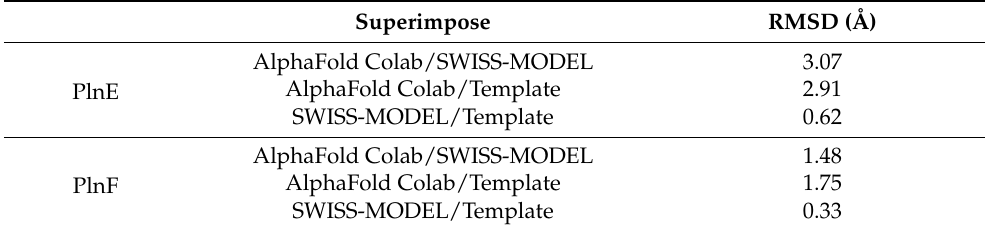
Table 5. RMSD values of predicted structures of PlnE and PlnF modeled by AlphaFold Colab and SWISS-MODEL, in comparing with each other or with